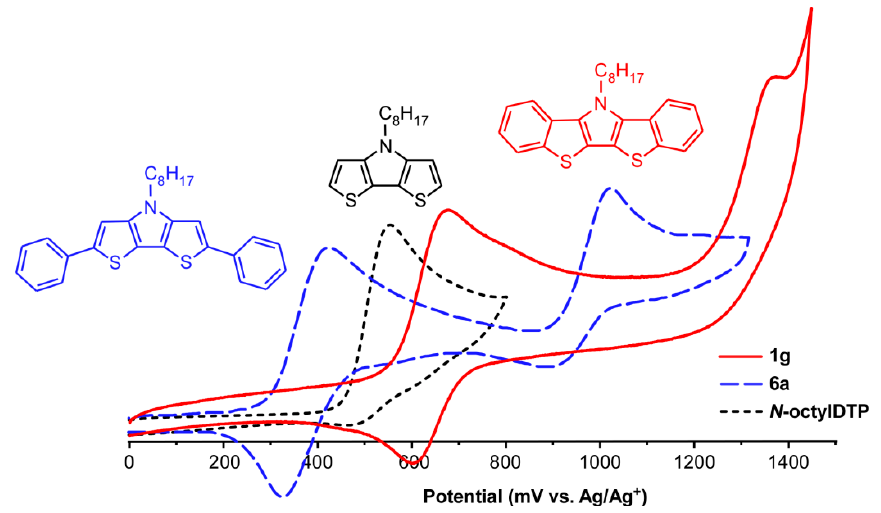
Figure 8. Cyclic voltammograms of N ‐ octylbis[1]benzothieno[3,2 ‐ b :2 ′ ,3 ′‐ d ]pyrrole ( 1g ), N ‐ octyl ‐ 2,6 ‐ diphenyldithieno[3,2 ‐ b :2 ′ ,3 ′‐ d ]pyrrole ( 6a ), and N ‐ octyldithieno[3,2 ‐ b :2 ′ ,3 ′‐ d ]pyrrole.